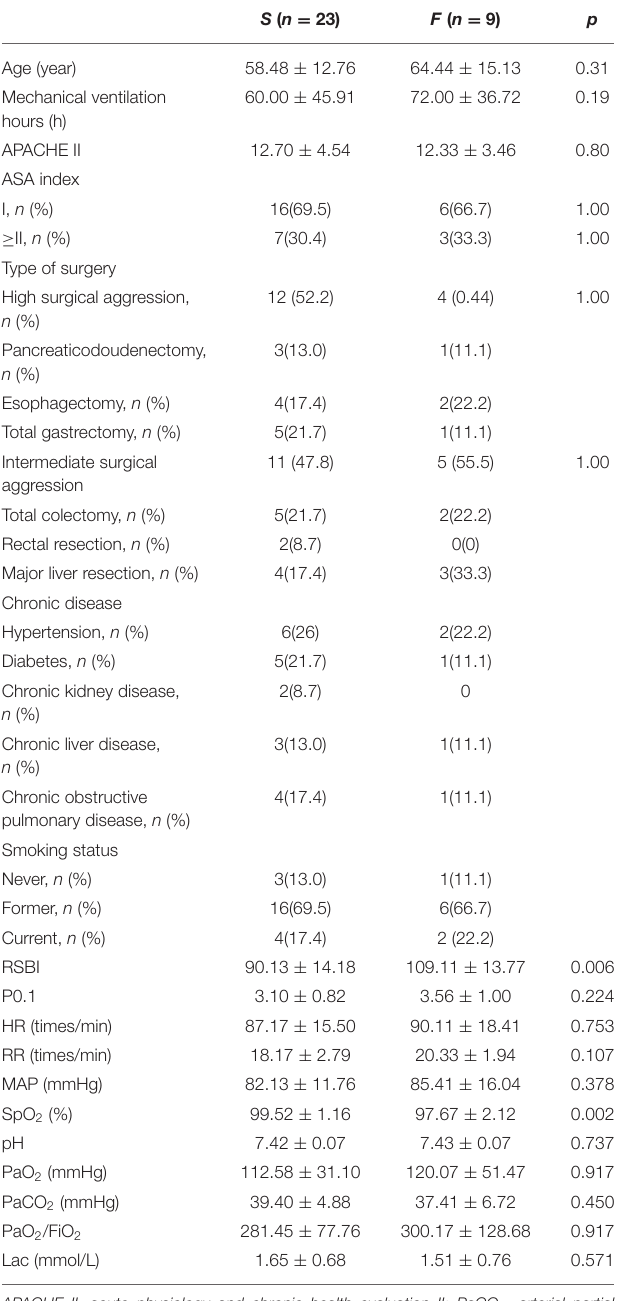
TABLE 1 | Baseline characteristics of patient is at SBT